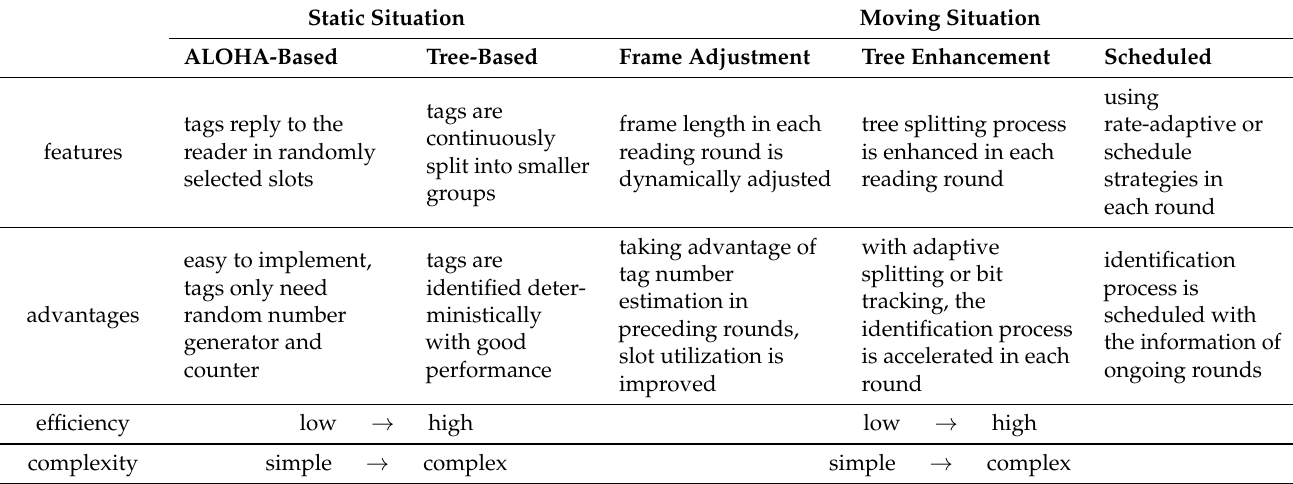
Table 1. Comparison of different RFID tag identification protocols in static and moving